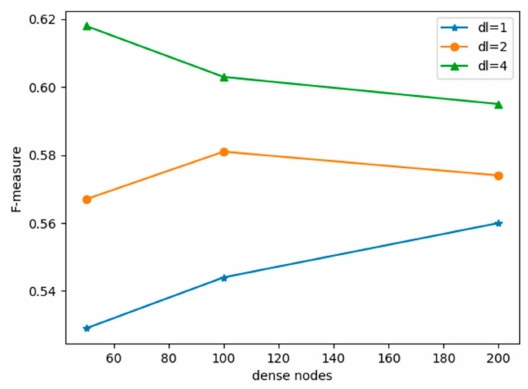
Figure 9. Dense layers and dense nodes. Here dl means dense